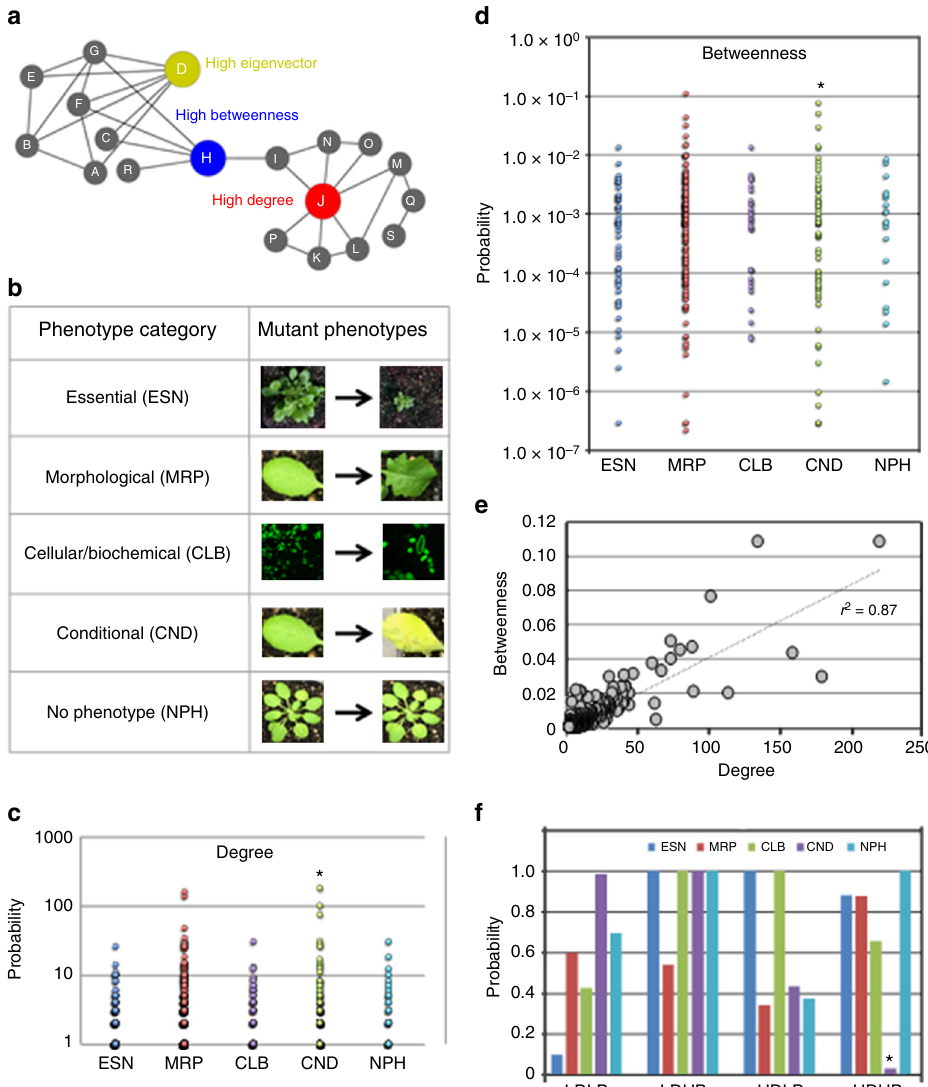
Fig. 1 Hubs and bottlenecks are enriched in conditional phenotypes. a Schematic representation of high degree (hub; red), high betweenness (bottleneck; blue), and high eigenvector (green) nodes in a hypothetical network. b Cataloging loss-of-function mutant phenotypes in Arabidopsis based on fi ve phenotypic groups: essential (ESN), morphological (MRP), cellular-biochemical (CLB), conditional (CND), and no phenotypes (NPH). c , d Node distribution corresponding to degree ( c ) and betweenness ( d ) for fi ve phenotypic groups. CND phenotype enrichment for hub and betweenness are shown. e Relationship between node betweenness and degree distribution to identify high degree/high betweenness (HDHB), high degree/low betweenness (HDLB), low degree/high betweenness (LDHB) as well as low degree/low betweenness (LDLB) nodes (correlation coef fi cient of r 2 = 0.87). f Hypergeometric test to determine the overrepresentation of a particular phenotypic group in nodes belonging to HDHB ( P = 0.03), HDLB ( P > 0.05), LDHB ( P > 0.05), and LDLB ( P > 0.05)